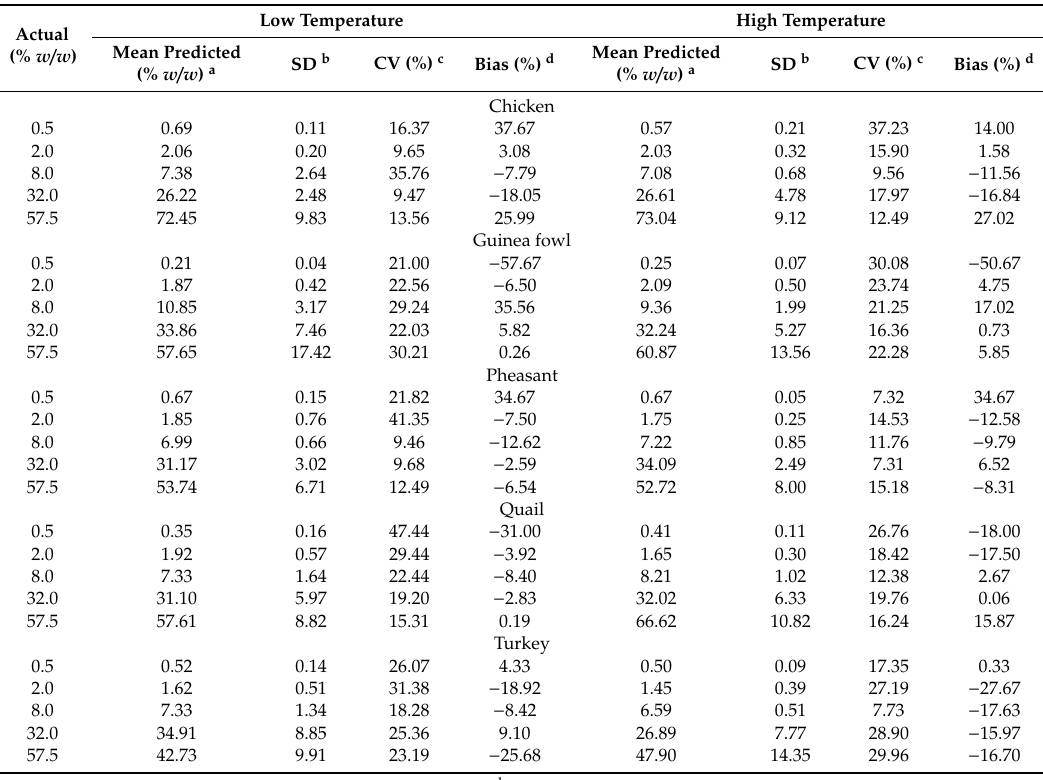
Table 7. Predicted concentrations of meat from five poultry species in unknown emulsified type sausages under two temperature conditions, quantified with an internal reference